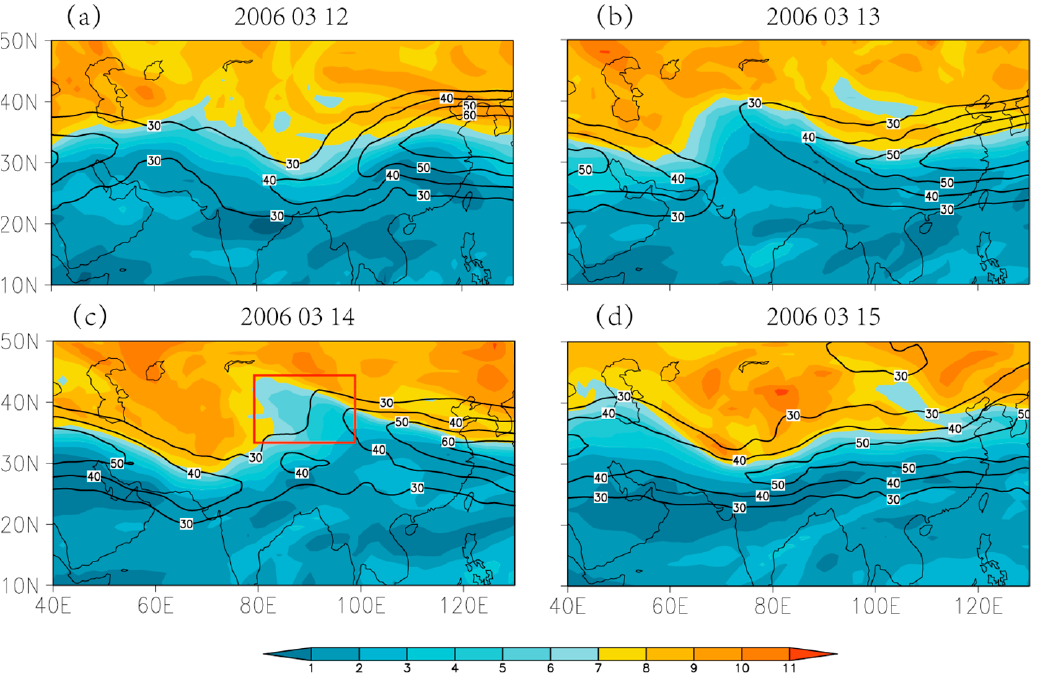
Figure 1. Diurnal evolution of the PV (shaded; unit: PVU, 1 PVU = 10 − 6 m 2 ⋅ s − 1 ⋅ K ⋅ kg − 1 ) and zonal wind (contours; unit: m ⋅ s − 1 ) on the 370-K isentropic surface at ( a ) 1200 UTC 12 March 2006, ( b ) 1200 UTC 13 March 2006, ( c ) 1200 UTC 14 March 2006 and ( d ) 1200 UTC 15 March 2006.